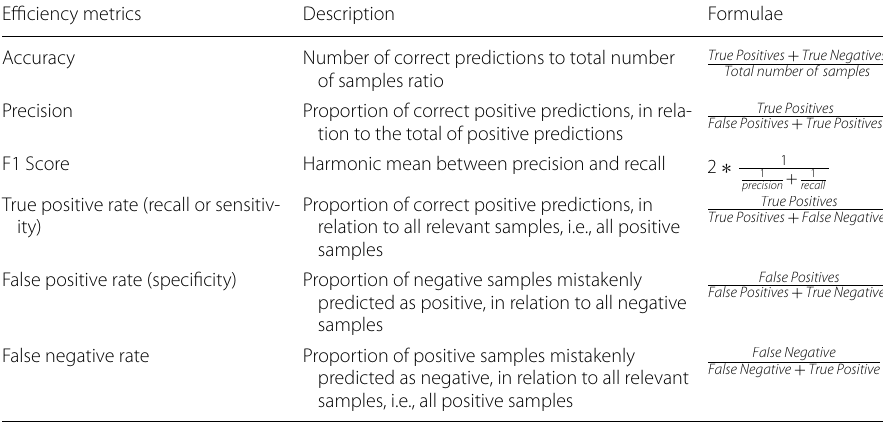
Table 13 Efficiency metrics description Efficiency